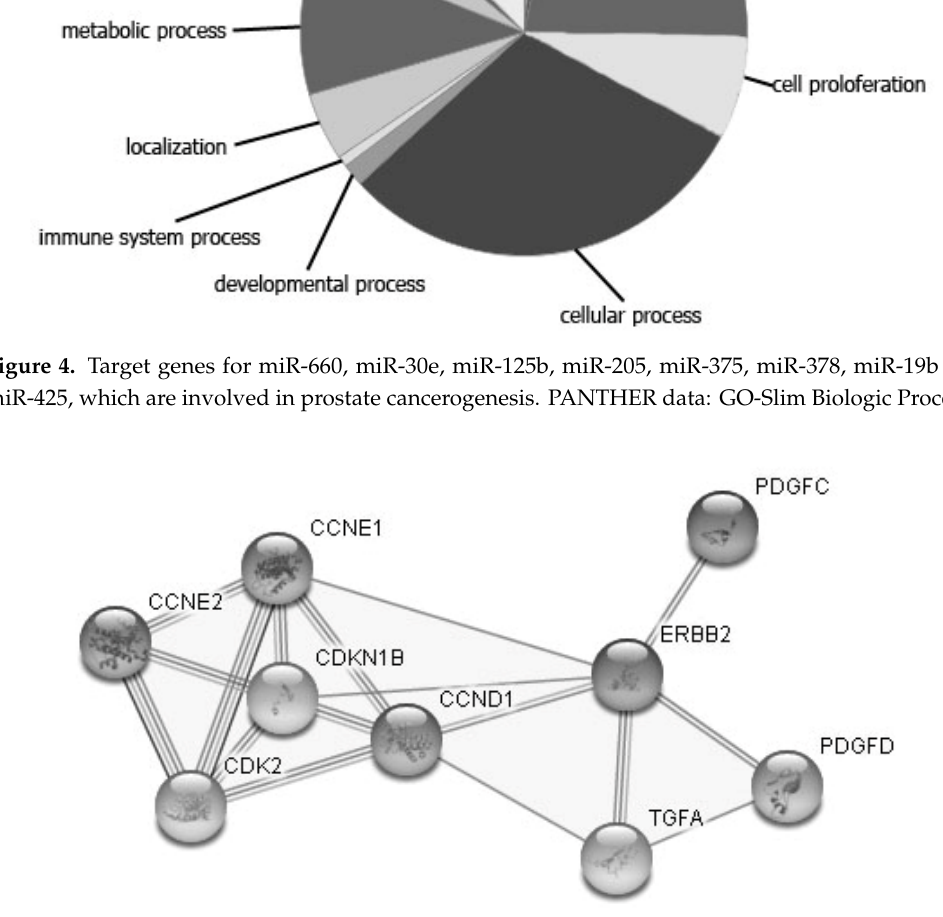
Figure 5. STRING data: Interactional network of the nine genes responsible for “cellular proliferation.”